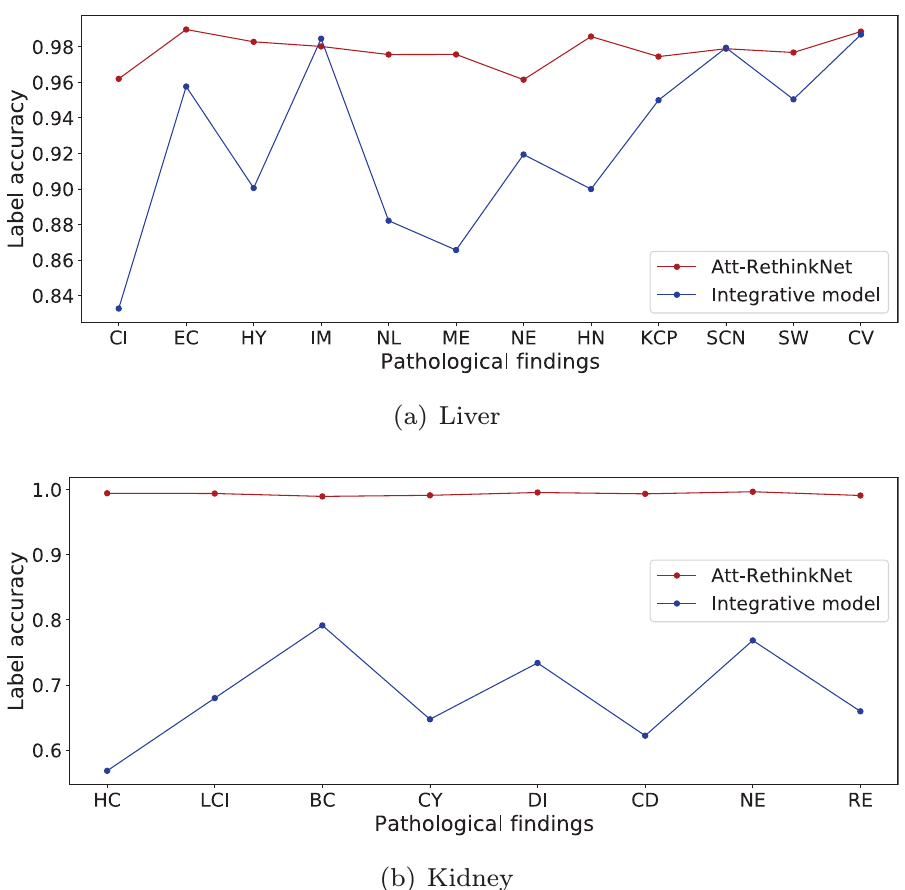
Fig 12. ACC lab comparison of the proposed model with the integrative model using liver samples (a) and kidney samples (b).